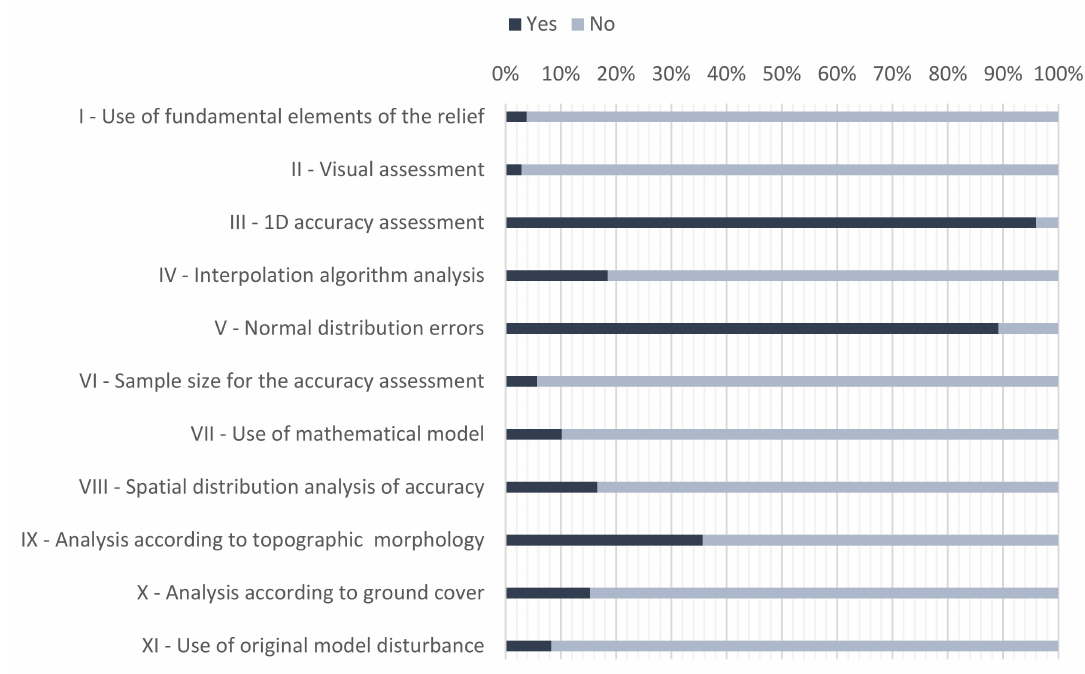
Figure 4. Distribution of percentages of the studies analyzed that meet various considerations in the accuracy assessment of studies in which visual assessment is carried